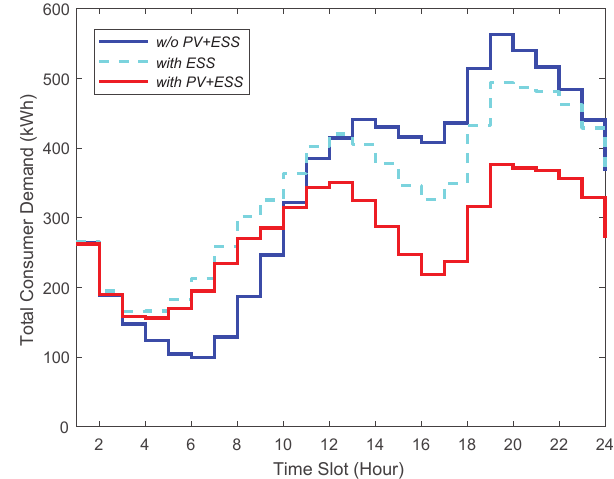
Figure 5. Comparison of total consumer demand.